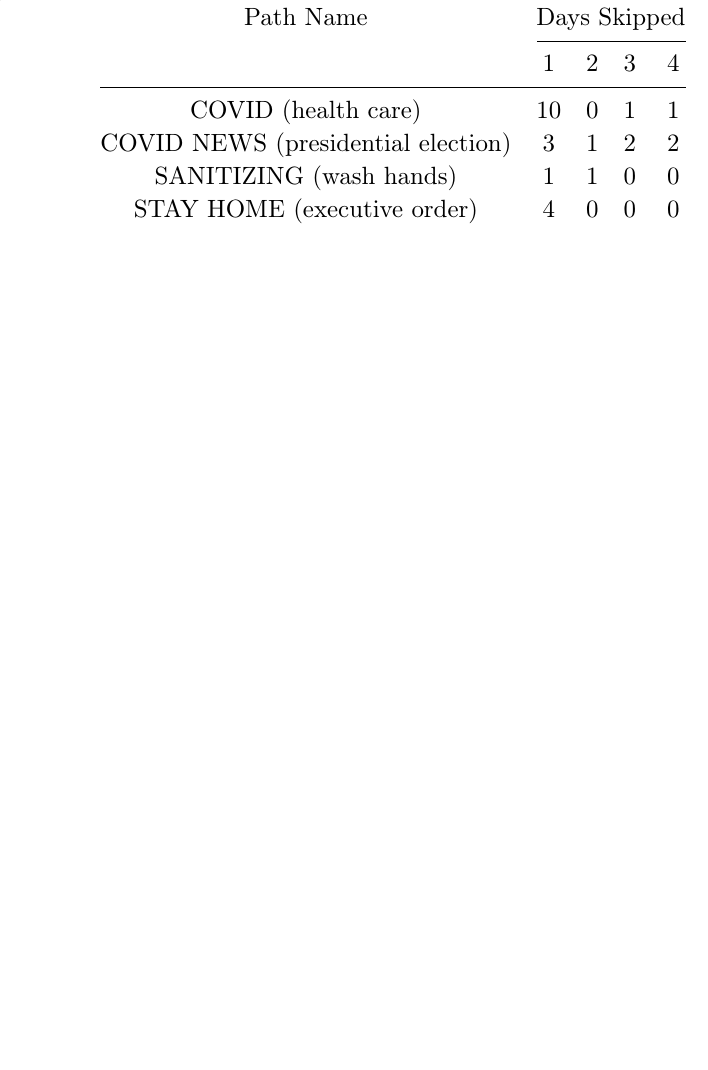
Table B.1. Summary of the number of skips along with the length of those skips for four different topic paths. The paths are discovered by the shortest path algorithm using 10 -nearest neighbor weighted graph. Note that all paths exhibit small numbers of short-length